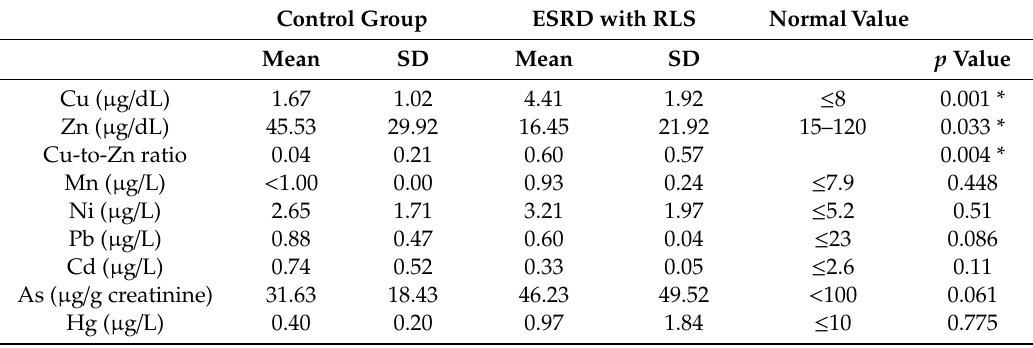
Table 4. Urinary concentration of heavy metals of participants grouped as control, ESRD witht RLS. Cu: Copper. Zn: Zinc. Mn: Manganese. Ni: Nickel. Pb: Lead. Cd: Cadmium. As: Arsenic. Hg: Mercury. Control Group ESRD with RLS NormalValue